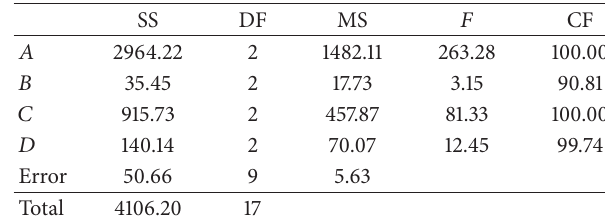
Table 5: Analysis of variance summary table of fatty acid